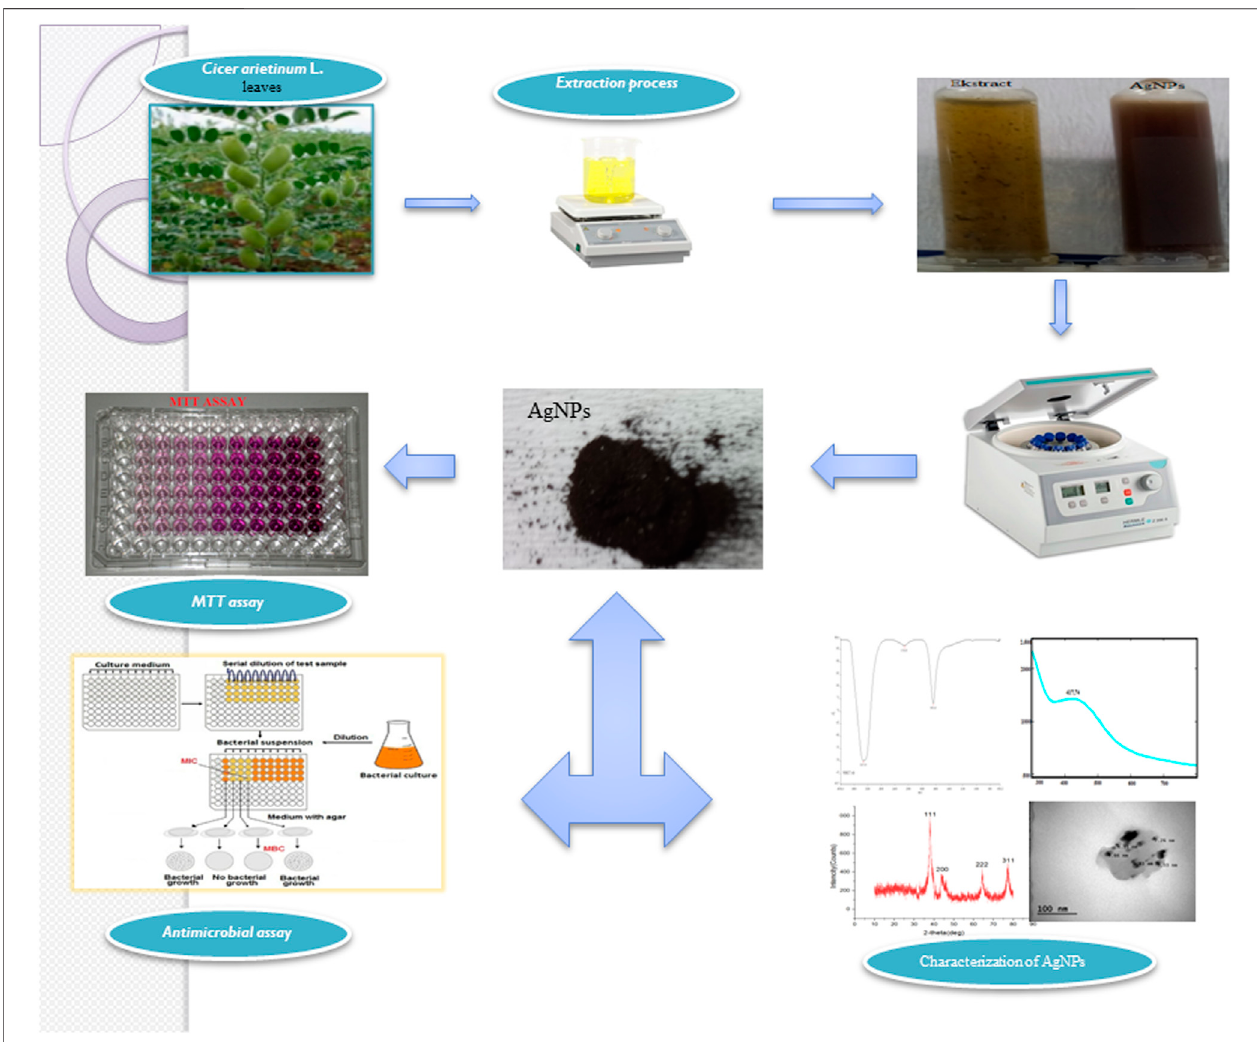
FIGURE 1 | Graphical illustration of the study.